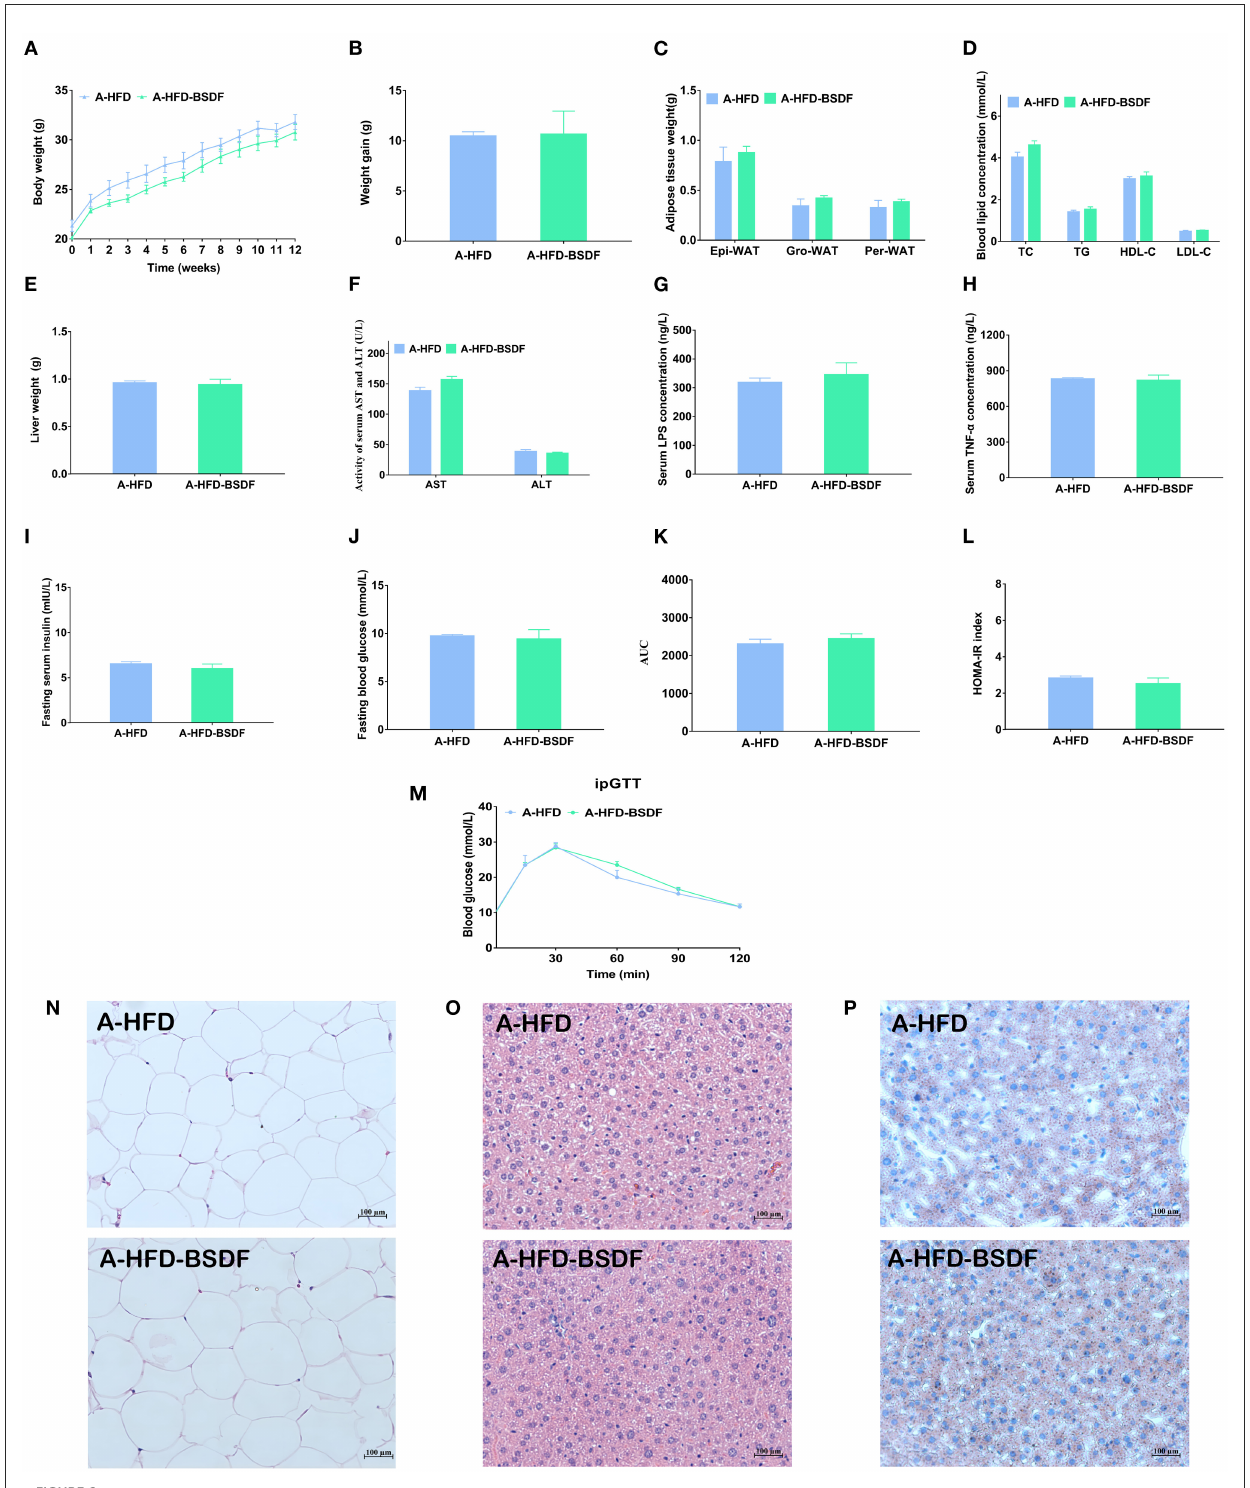
FIGURE6 Effects of BSDF administration on phenotype and insulin resistance in antibiotic-treated mice. (A) Bodyweight time course measurements, (B) Weight gain, (C) White fat weight, (D) Serum lipid profile, (E) Liver weight, (F) Serum ALT and AST concentrations (G) Serum LPS concentrations. (H) Serum TNF- α concentrations. (I) Serum glucose, (J) Serum insulin, (K) Area under the curve (AUC) of the blood glucose during ipGTT. (L) Homeostatic model assessment for insulin resistance (HOMA-IR) index, (M) Time courses of blood glucose levels in the intraperitoneal glucose tolerance test (iPGTT), (N) H&E staining of epididymal fat sections. (O) H&E staining of liver tissue, and (P) Liver Oil Red O staining. Data presented as mean ± SEM, n = 8 per group. A-HFD vs. A-HFD-BSDF at p < 0.05. A-HFD, high-fat diet and antibiotic water; A-HFD-BSDF, high-fat diet supplemented with 6% BSDF freeze-dried powder and antibiotic